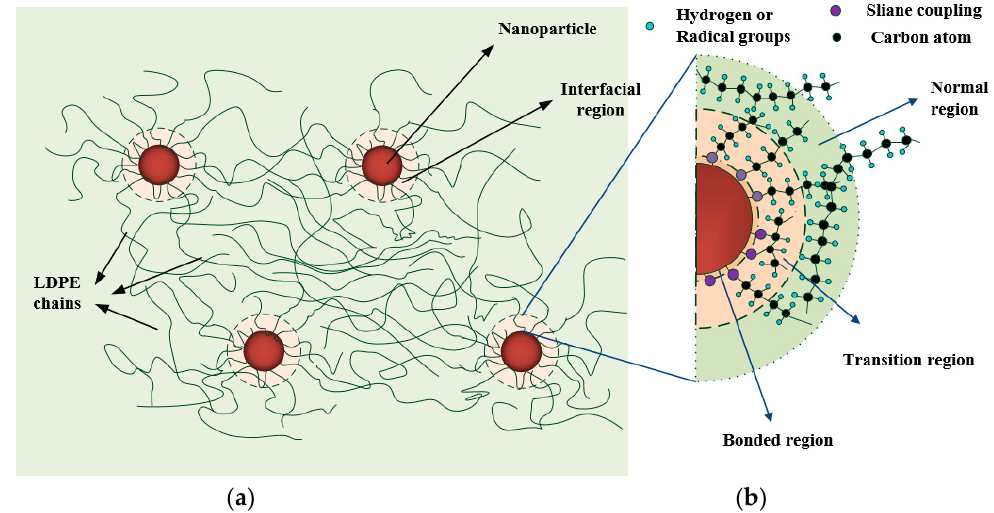
Figure 9. Interface region and morphology caused by surface modification of nanoparticles in LDPE/TiO 2 nanocomposites. ( a ) Distributed nanoparticles with interface in LDPE matrix; ( b ) morphology in the interface region due to physicochemical interactions.